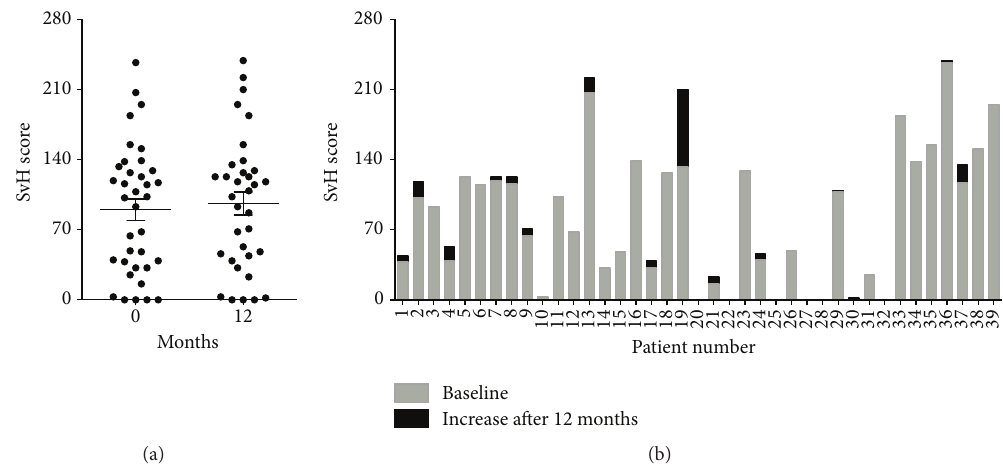
Figure 2: Progression of joint erosion. Erosions in the affected joints of the RA cohort, where the 𝑦 -axes represent the Sharp/van der Heijde scores; (a) the 𝑥 -axis illustrates the two assessment time points indicated as 0 and 12 months after treatment in a paired 𝑡 -test; (b) the 𝑥 -axis represents the patients’ individual progression in joint erosion in a histogram, where the grey bars illustrate baseline joint erosions and the black bars illustrate additional joint erosions after 12